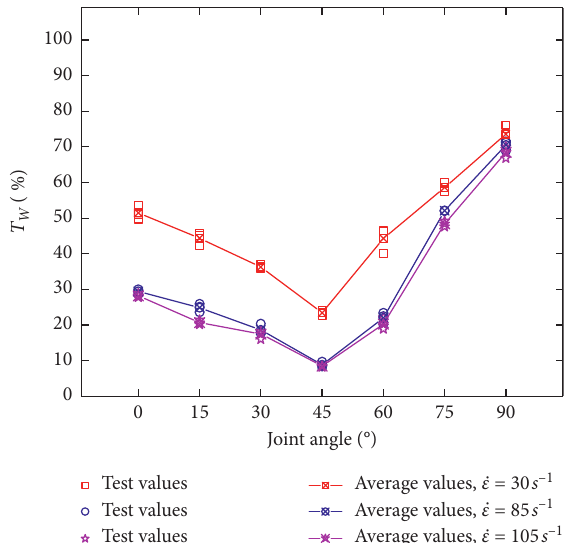
Figure 11: Variation in W with joint angle under three different strain rates.